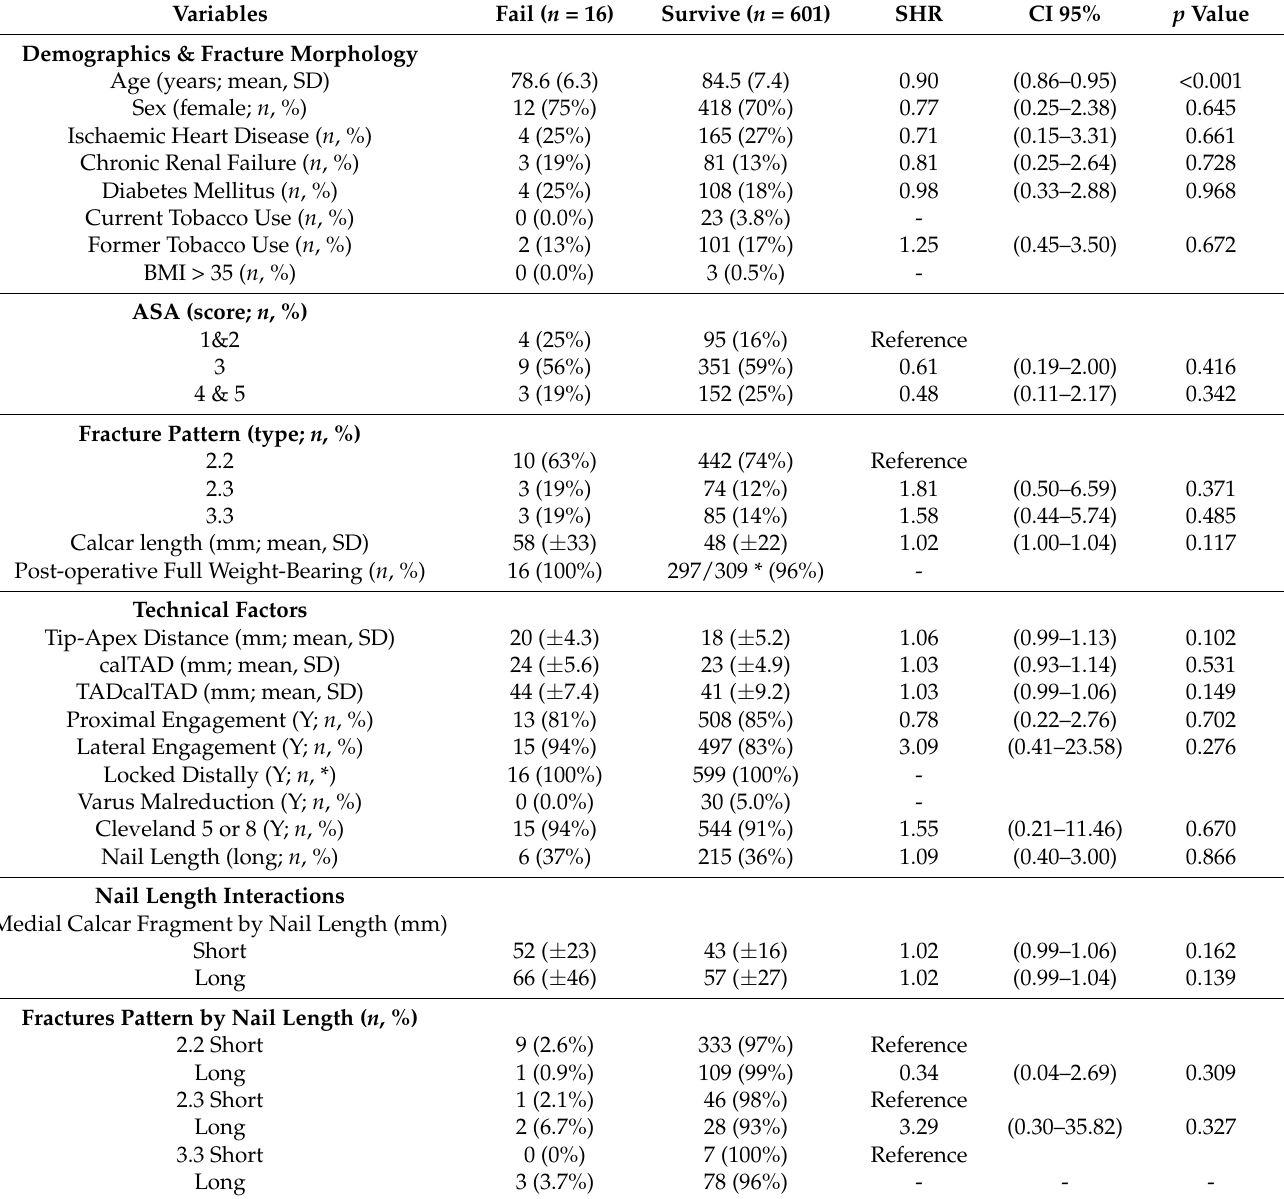
Table A2. Univariate Analysis of Independent